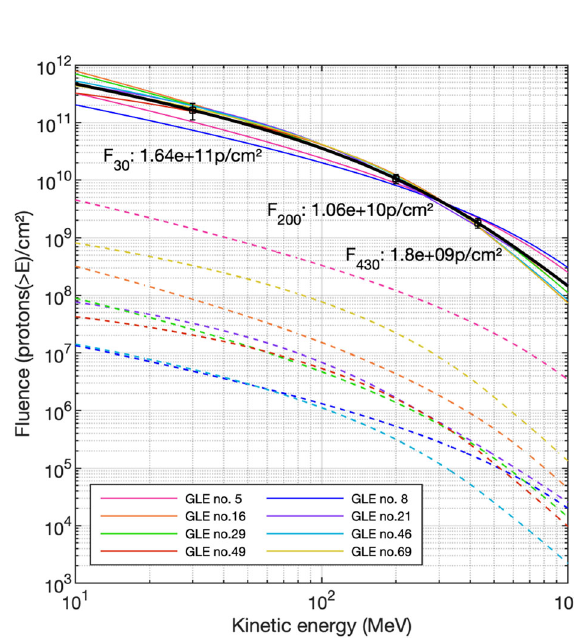
Fig. 2 Event-integrated fl uence spectra (assuming an average Φ = 650 MV). The dashed curves represent the original spectra of the modern events that fi t the 36 Cl/ 10 Be ratio of the 9125 years BP event. The scaled spectra are shown as continuous lines. The black line shows the average fl uence spectrum. The fl uences above 30, 200, and 430 MeV (F 30 , F 200 and F 430 ) of the average spectrum are reported. The uncertainties of the fl uence estimates include the uncertainty of the 10 Be enhancement factor and the standard deviation of the scaled spectra.